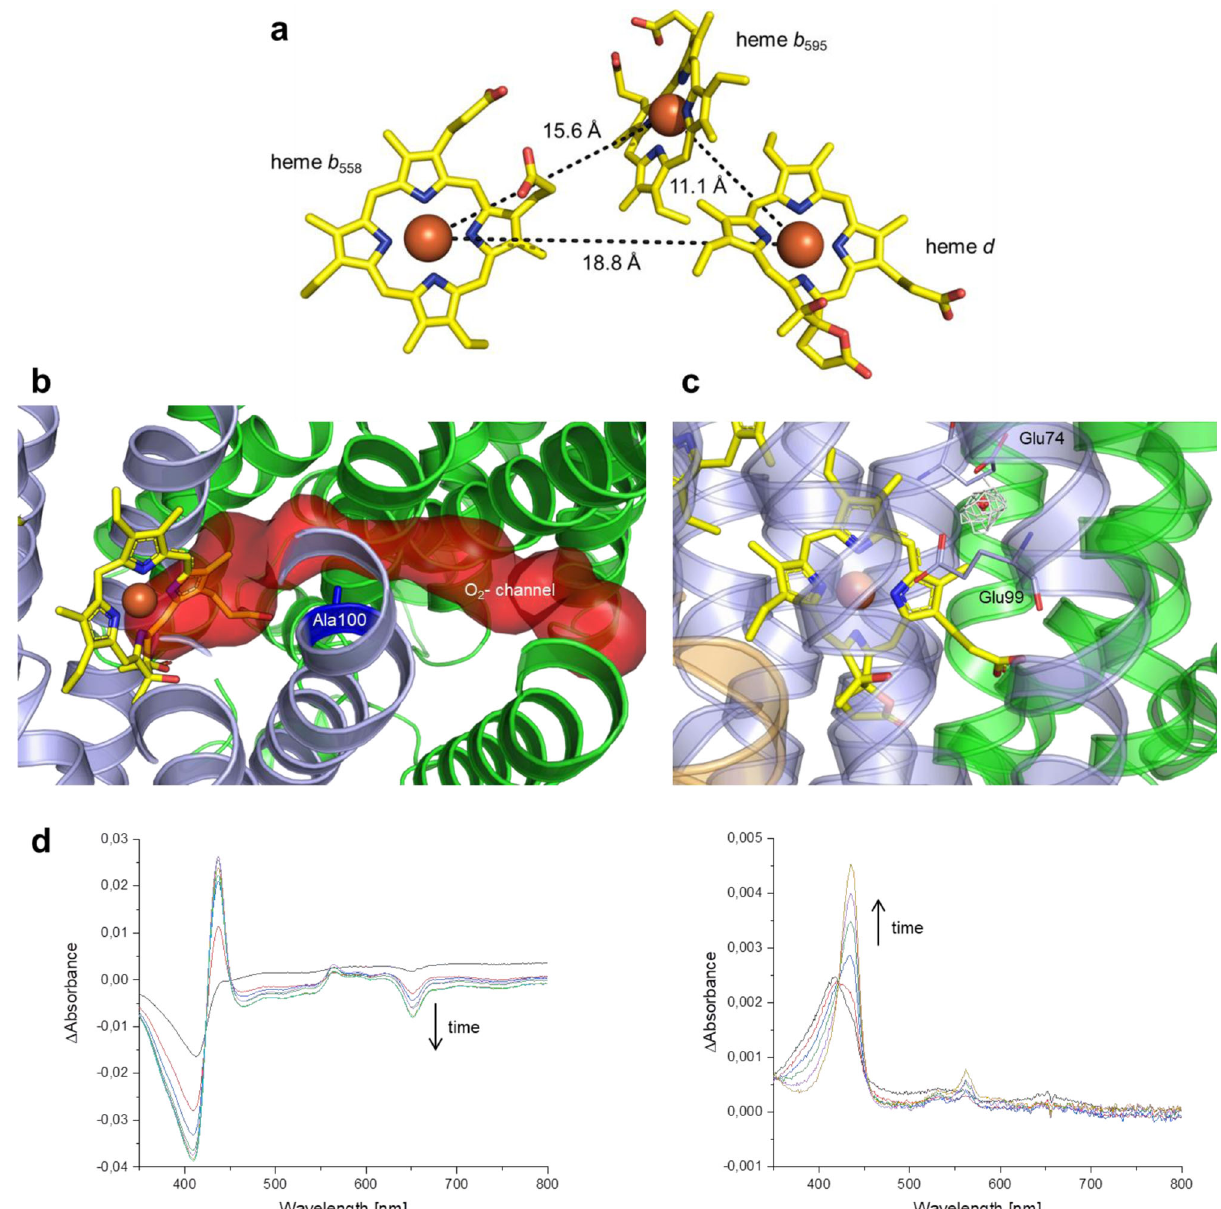
Fig. 4 Arrangement of heme groups in bd -II and substrate binding. a Arrangement of heme groups in AppC of E. coli bd -II. b Channel from AppB to heme d . The channel identi fi ed by Caver is shown in red. Ala100 (dark blue, shown as sticks) constricts the channel diameter. c Electron density next to heme d that could be caused by the substrate dioxygen. d UV-vis difference spectra of bd -II incubated with CN − over 30 min (left) and reduction of the CN − -treated sample with dithionite